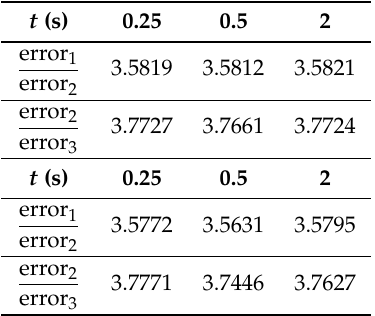
Table 5. Convergence order computed in l 2 and l ∞ norms for the imaginary parts, respectively.